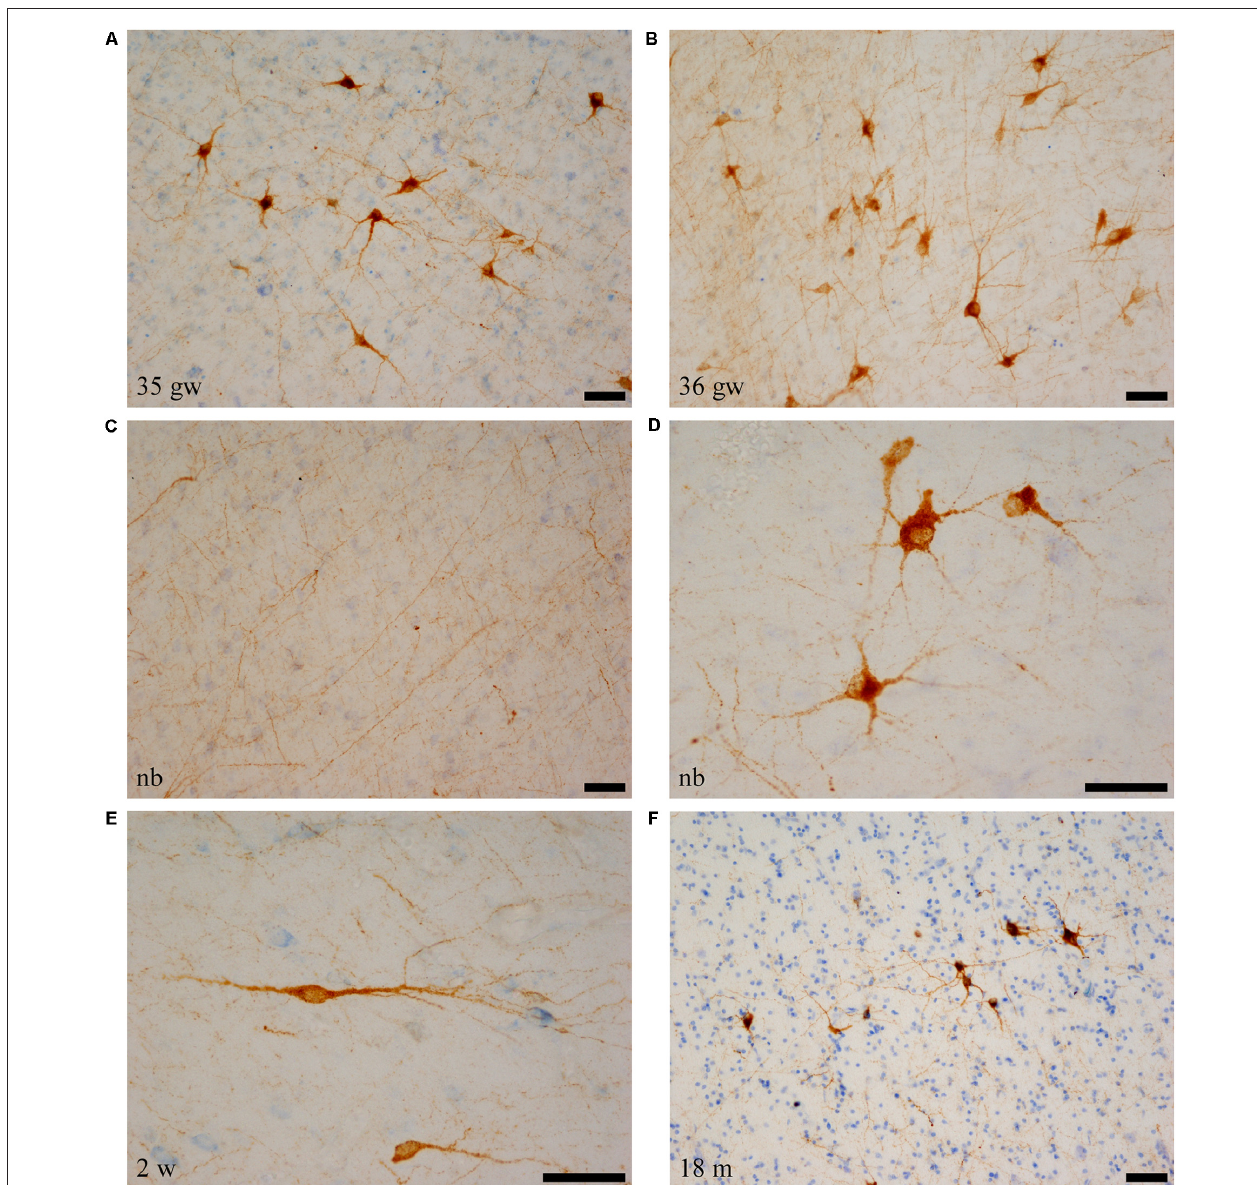
FIGURE 4 | SOM-28-positive neurons and fibers in the angular bundle white matter. Note the polygonal (panel D , newborn, case 5), spindle-shaped neurons (panel E , case 7, 2 weeks), or mixed morphology population (A,B,F) . Fibers containing SOM-28 are presented in panel C . Note that the youngest ages show the most detailed morphology. Microphotographs (A,E) correspond to rostral levels of the hippocampus; Pictures (B–D,F) are at midlevel of the hippocampus. Scale bar is 50 µ